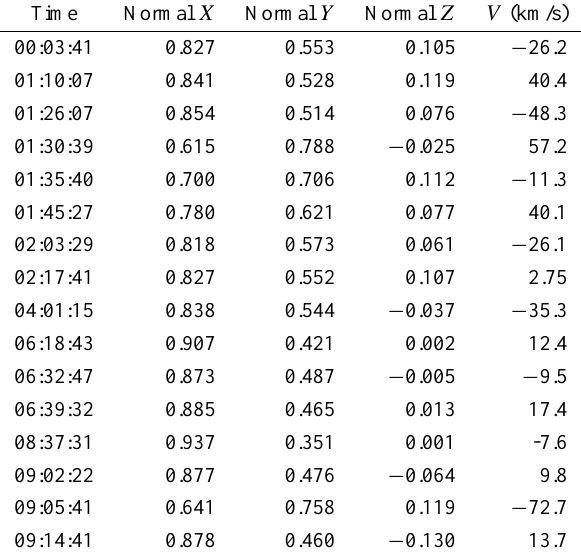
Table 1. Bowshock crossings on 25 December 2000. Times listed are for spacecraft 1. Normal unit vector estimates in GSE coordi- nates are shown as well as velocities of the shocks, where negative velocities correspond to inward bowshock motion and vice versa